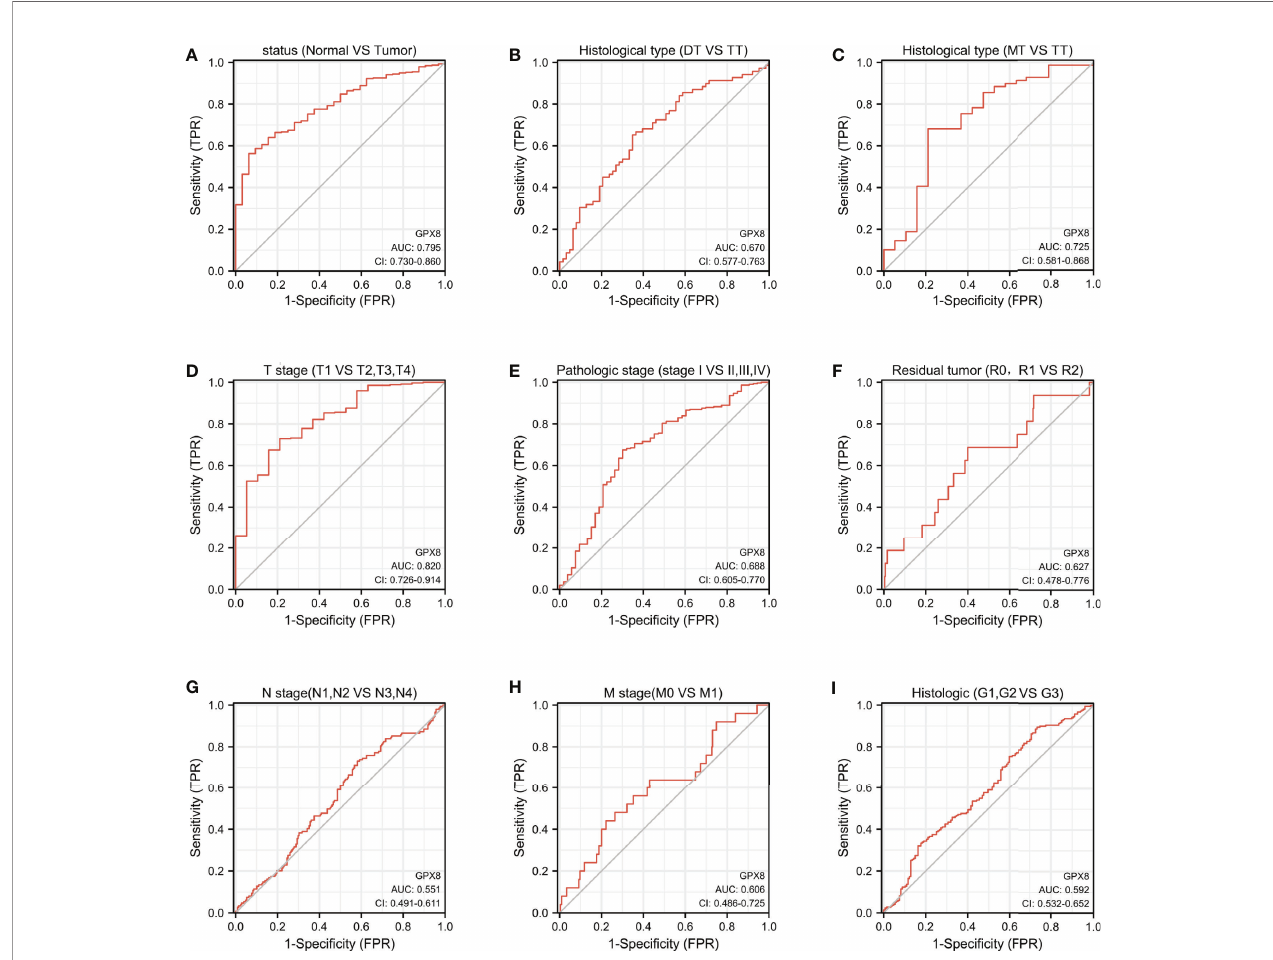
FIGURE 4 | ROC curve was used to analyze the diagnostic effect of GPX8 in distinguishing outcomes between different subgroups. (A) status (Normal vs Tumor); (B) Histological type (DT vs TT); (C) Histological type (MT vs TT); (D) T stage (T1 vs T2, T3, T4); (E) Pathologic stage (stage I vs II, III, IV); (F) Residual tumor (R0, R1 vs R2); (G) N stage (N1, N2 vs N3, N4); (H) M stage (M0 vs M1); (I) Histologic (G1, G2 vs G3). Note: The value of the area under the ROC curve is between 0.5 and 1. The closer the AUC is to 1, the better the diagnostic effect. AUC has low accuracy when it is 0.5 ∼ 0.7, it has certain accuracy when AUC is 0.7 ∼ 0.9, and it has high accuracy when AUC is above 0.9. DT, Diffuse Type; TT, Tubular Type; MT, Mucinous Type; R0, no residual tumor; R1, microscopic residual tumor; R2, macroscopic residual tumor; G1, Grade 1; G2, Grade 2; G3, Grade